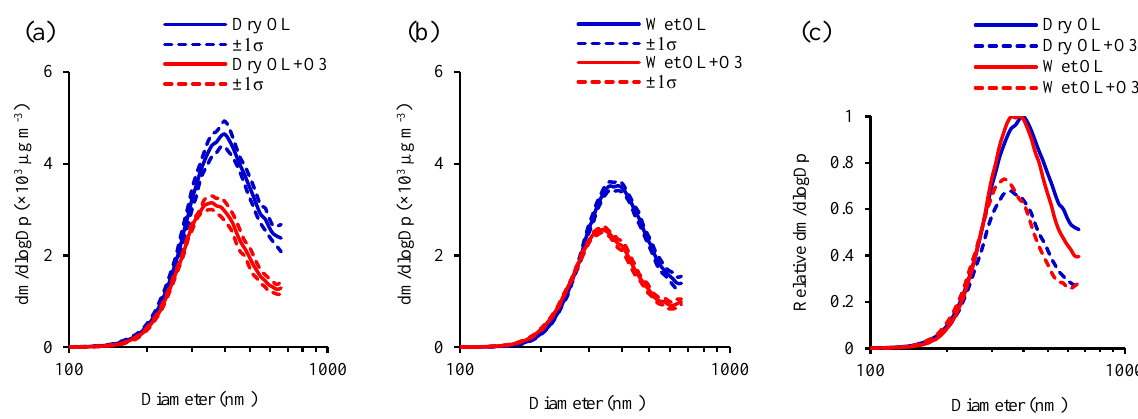
Figure 2. Particle mass size distributions for (a) pure and oxidised OL aerosol under dry condition (RH 0. ± 0.02%), (b) pure and oxidised OL aerosol under wet condition (RH 65.0 ± 0.2%), and (c) normalised particle size distribution of pure and oxidised OL aerosol under dry and wet conditions. Each curve represents the mean average of 10 measurements with accompanying standard deviation ( σ)